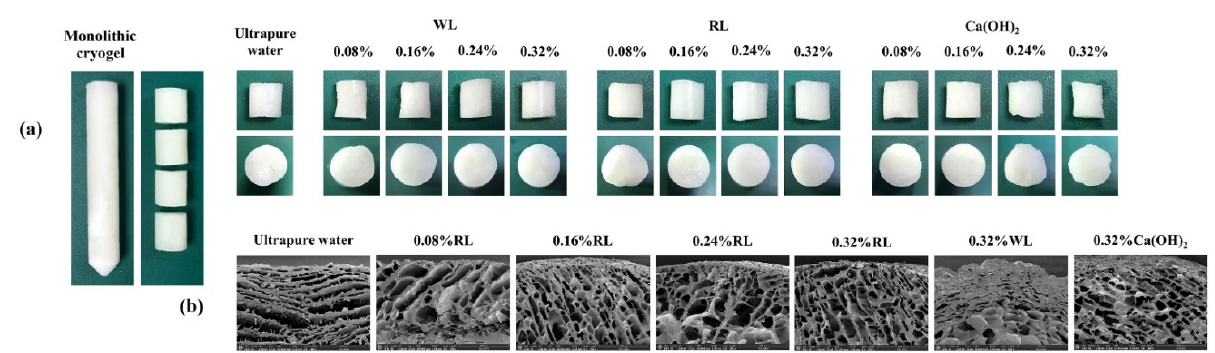
Figure 1. ( a ) The cryogels obtained with various amounts of red lime (RL), white lime (WL) and calcium hydroxide standard solution (Ca(OH) 2 ) prepared using the limewater on the day of its preparation with one freeze–thaw-cycle, and ( b ) their FE-SEM images.